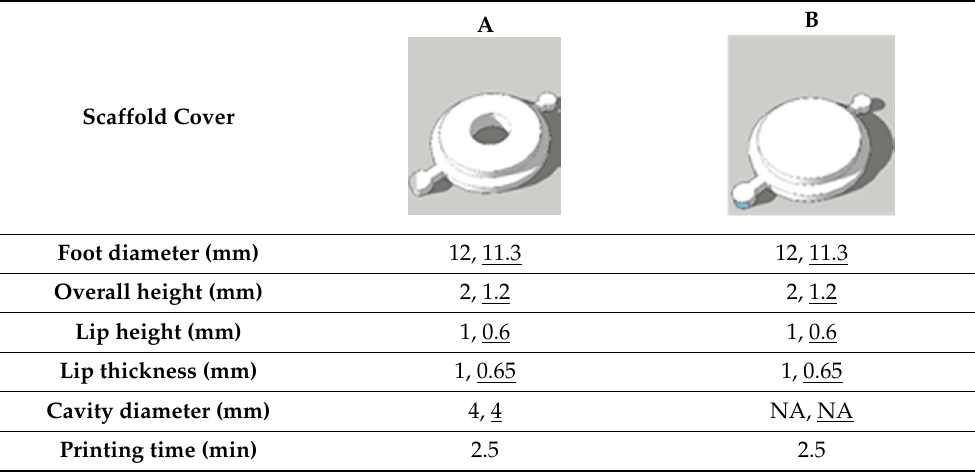
Table 3. Geometry of virtual multicompartment scaffolds used to print physical multicompartment scaffolds from PVOH filament.